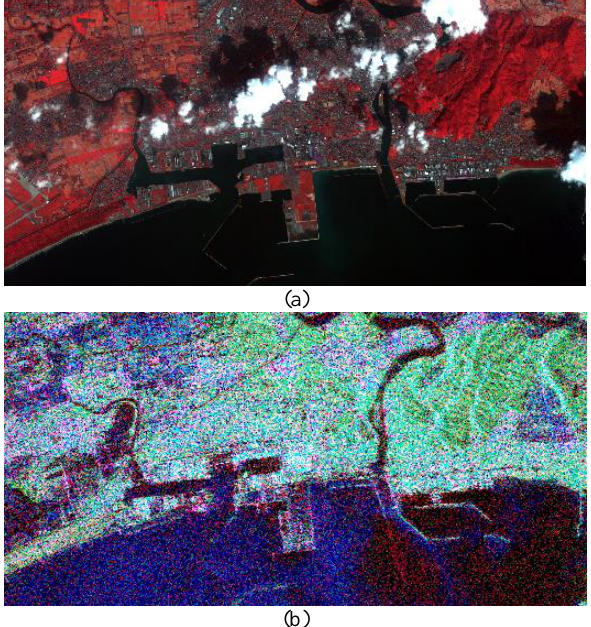
Figure 1. (a) False colour (NIR-G-B) image of the KOMPSAT- 2 data; (b) Pauli RGB image of the ALOS/PALSAR-1